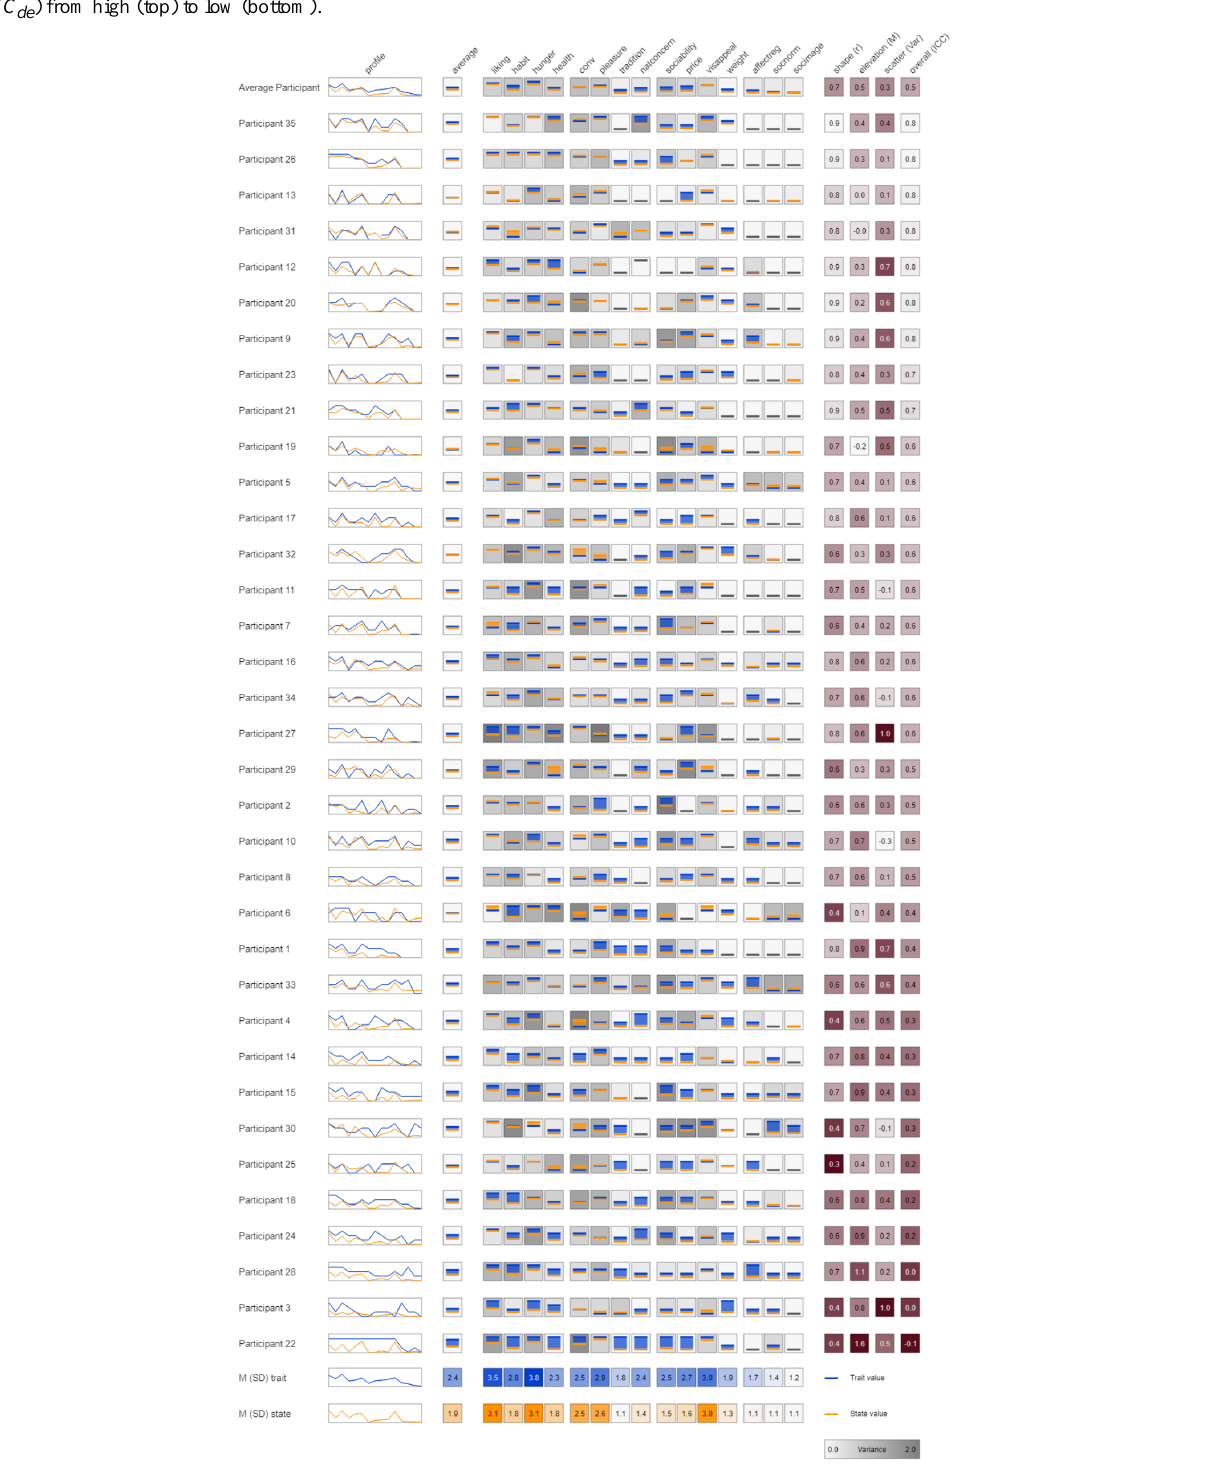
Figure 4. Visualized full person x motive data matrix. Participants are arranged in descending order according to the overall motive profile similarity ( ICC de ) from high (top) to low